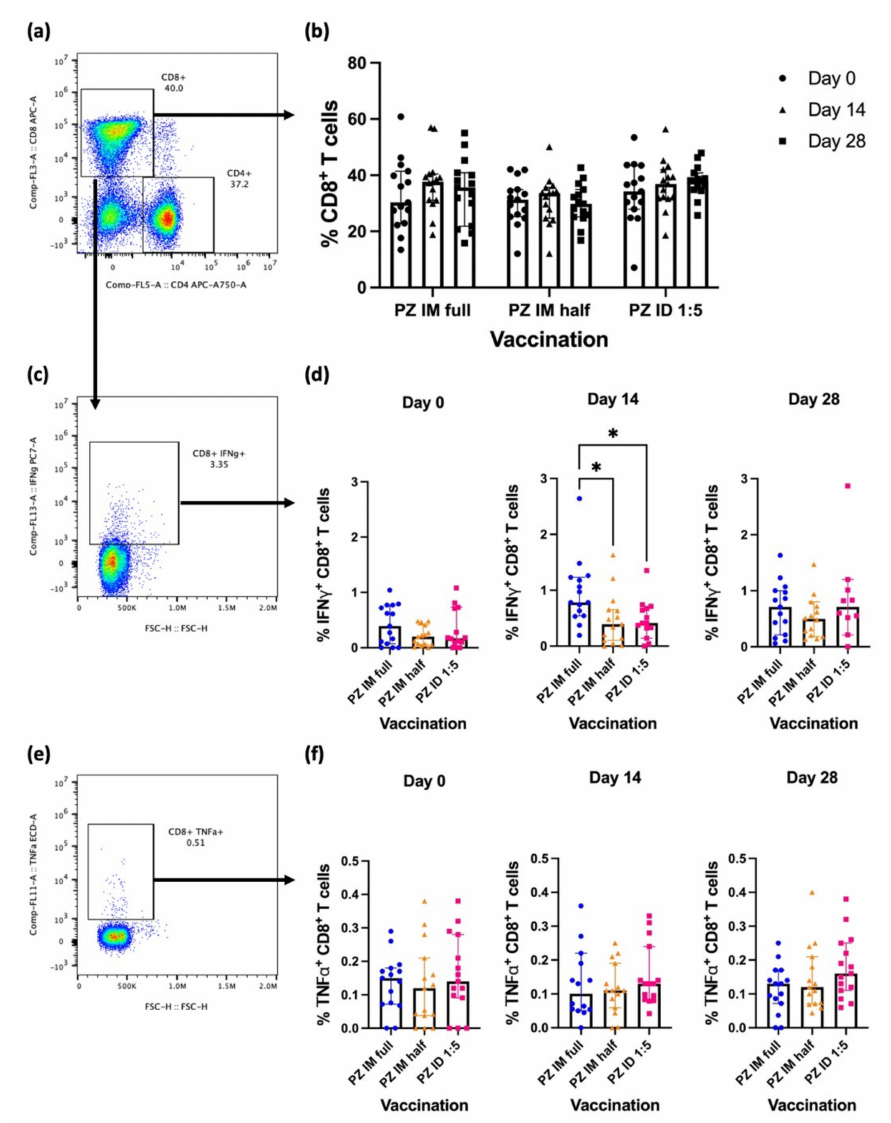
Figure 2. Effector cytokine production of S1-specific CD8 + T-cells after BNT162b2 boosting. All volunteers were previously vaccinated with two doses of inactivated SARS-CoV-2 vaccines (n = 91). The BNT162b2 mRNA booster vaccine was administered in three groups: intramuscularly with either full dosage (n = 30), or half dosage (n = 30), and intradermally with fractional dosage (n = 31). ( a ) CD4 + T-cell and CD8 + T-cell populations, ( b ) percentage of CD8 + T-cells at Day 0 (before